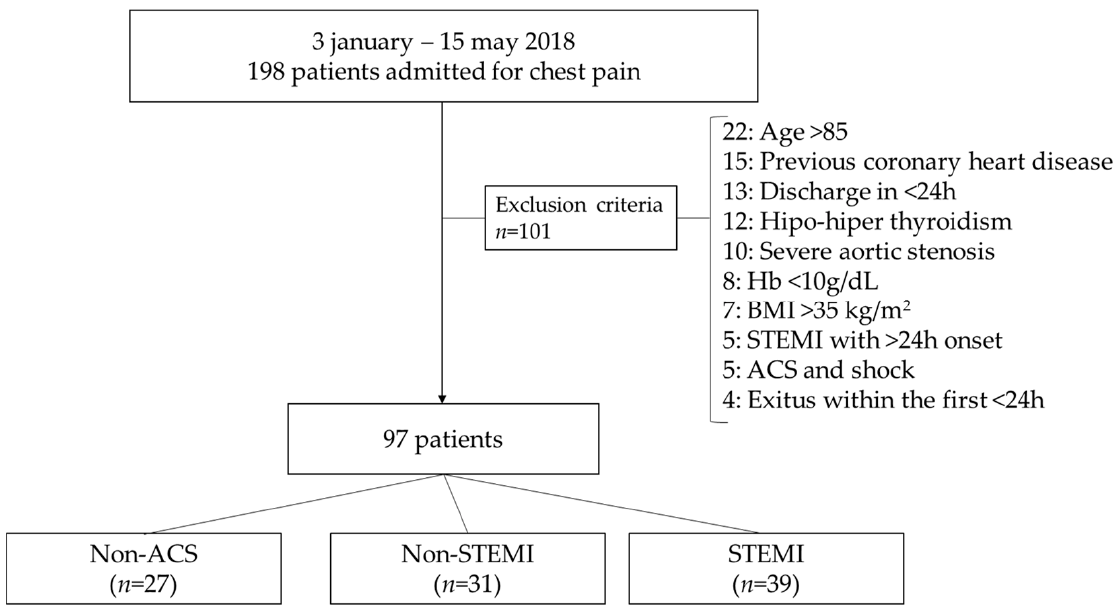
Figure 3. Flowchart of patient selection and exclusion criteria. Exclusion criteria includes the number of patients excluded for each criteria.